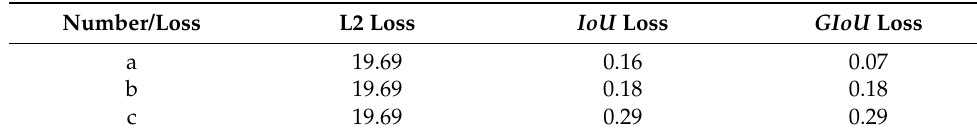
Table 1. The loss values of L2, IoU loss, and GIoU loss.